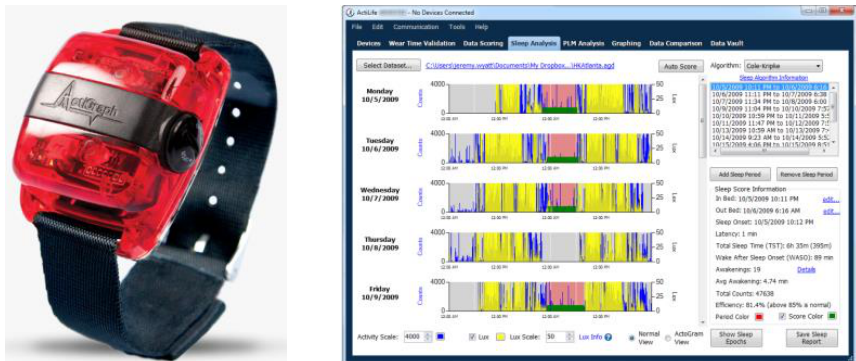
Figure 9. Wrist sleep actigraph (ActiGraph wGT3X-BT) and Actilife’s Figure 9. wrist sleep actigraph (ActiGraph wGT3X-BT ) and Actilife ’ s interface.